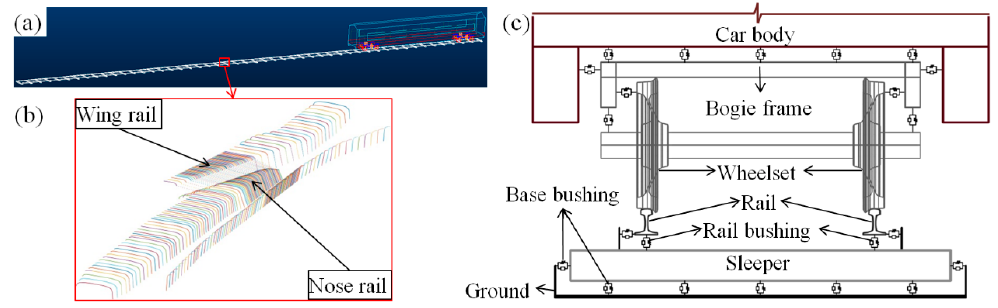
Figure 18. MBS model. ( a ) Vehicle-track model; ( b ) crossing profiles; ( c ) flexible connections in the model.